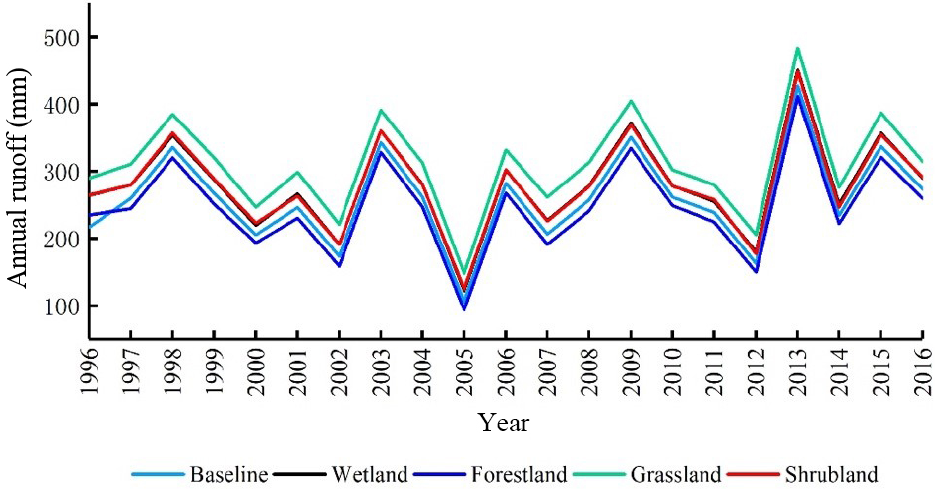
Figure 4. Land-use types in the Tahe River Basin in different years.